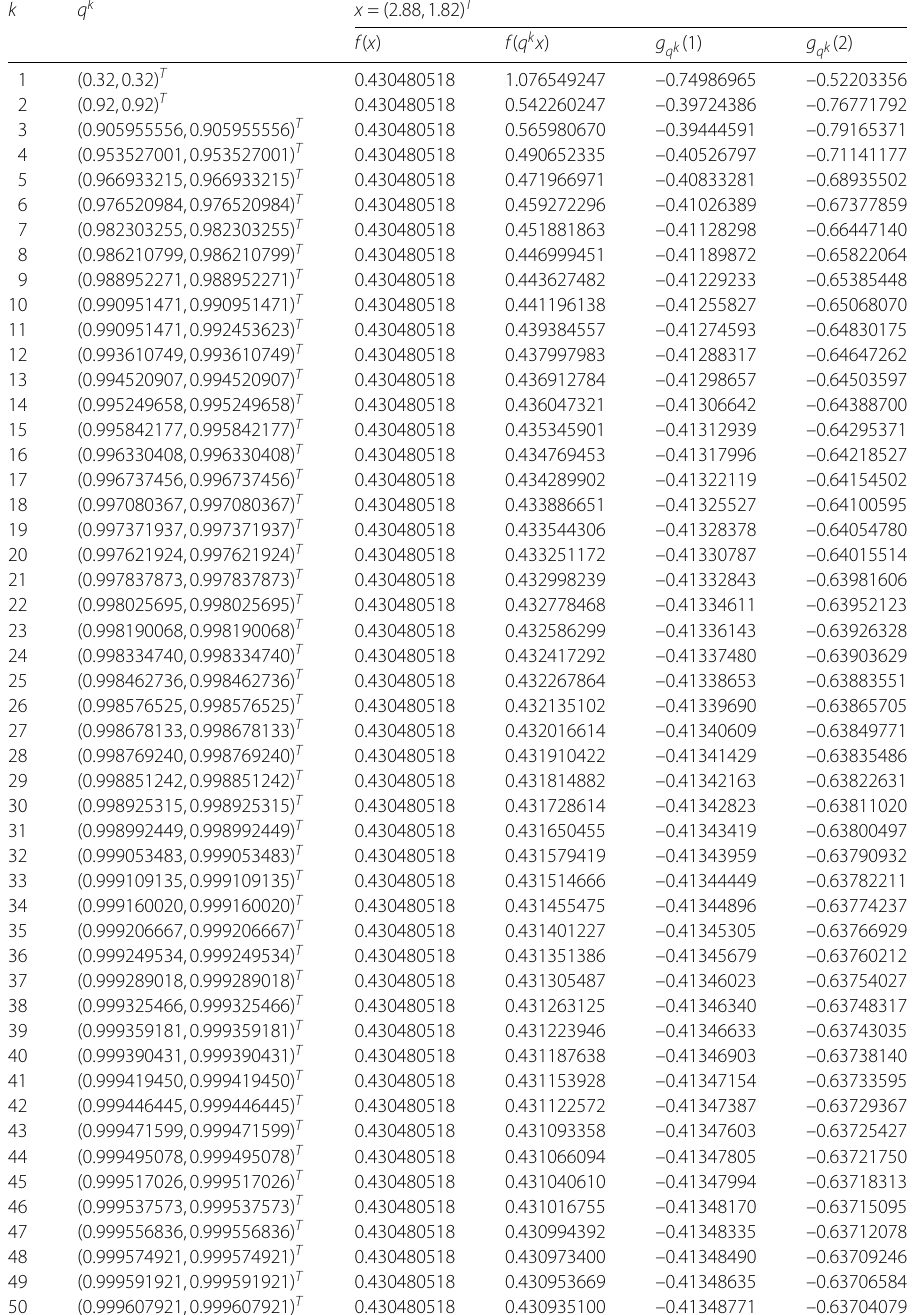
Table 1 q -Gradient of Example